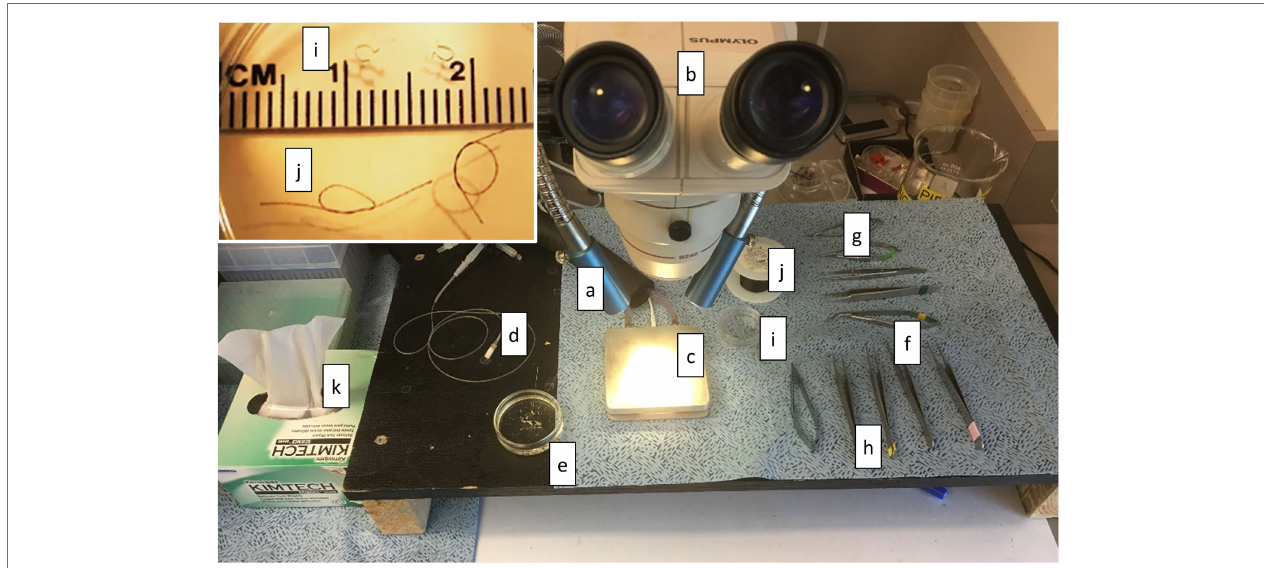
FIGURE 7 | Muscle Preparation Station. The equipment and tools required to prepare muscle are shown here. (a) lighting, (b) dissection microscope, (c) cooling plate and circulator, (d) bubbling stone for delivering gases, (e) at least one shallow glass dish with a clear silicon or rubber bottom and dissection pins filled half way with Dissection Solution, (f) small scissors (~10–20 mm blade), (g) smaller scissors (~2–4 mm blade), (h) at least two pairs of forceps, (i) at least two platinum omega-shaped clips in a small glass or clear plastic dish (see inset), (j) 7-O silk suture with at least two double-thrown loops also in the dish (see inset), and (k) laboratory